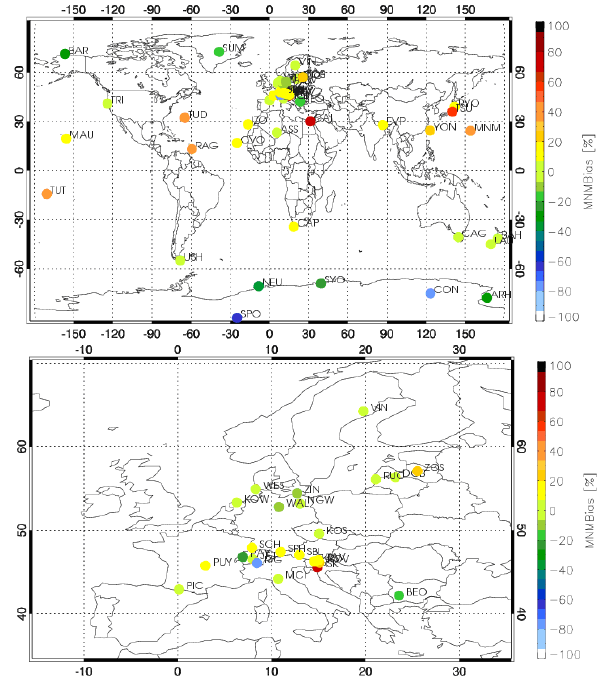
Figure 2. Modified normalised mean biases (MNMBs) [%] derived from the evaluation of the MACC_osuite with GAW O 3 surface observations during the period September 2009 to December 2012 globally (top), and for Europe (bottom). Blue colours represent large negative values and red/brown colours represent large positive